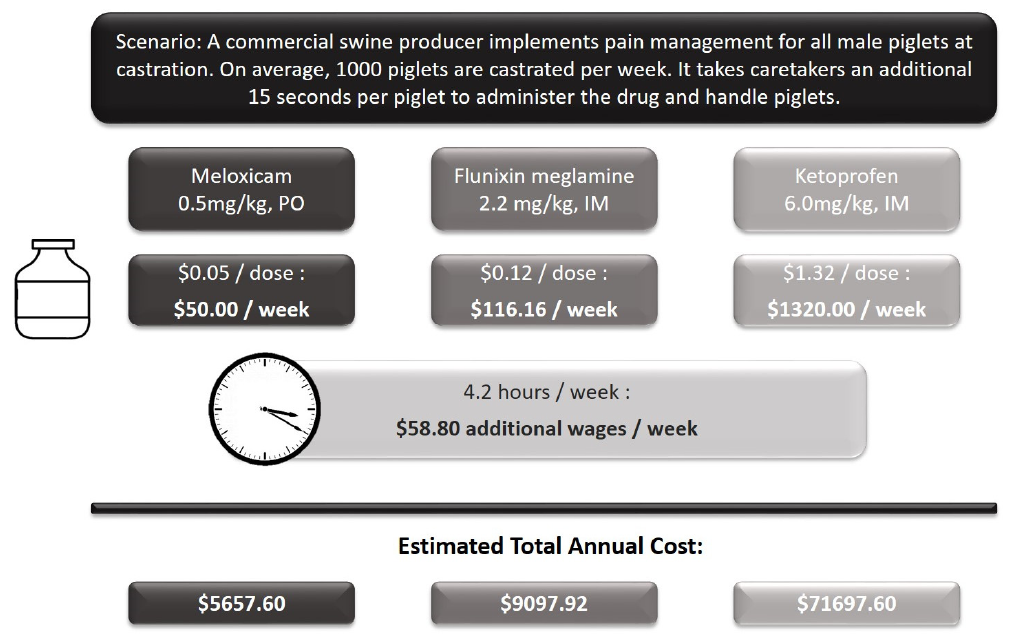
Figure 1. An example scenario of pain management implementation costs (presented as US dollars).